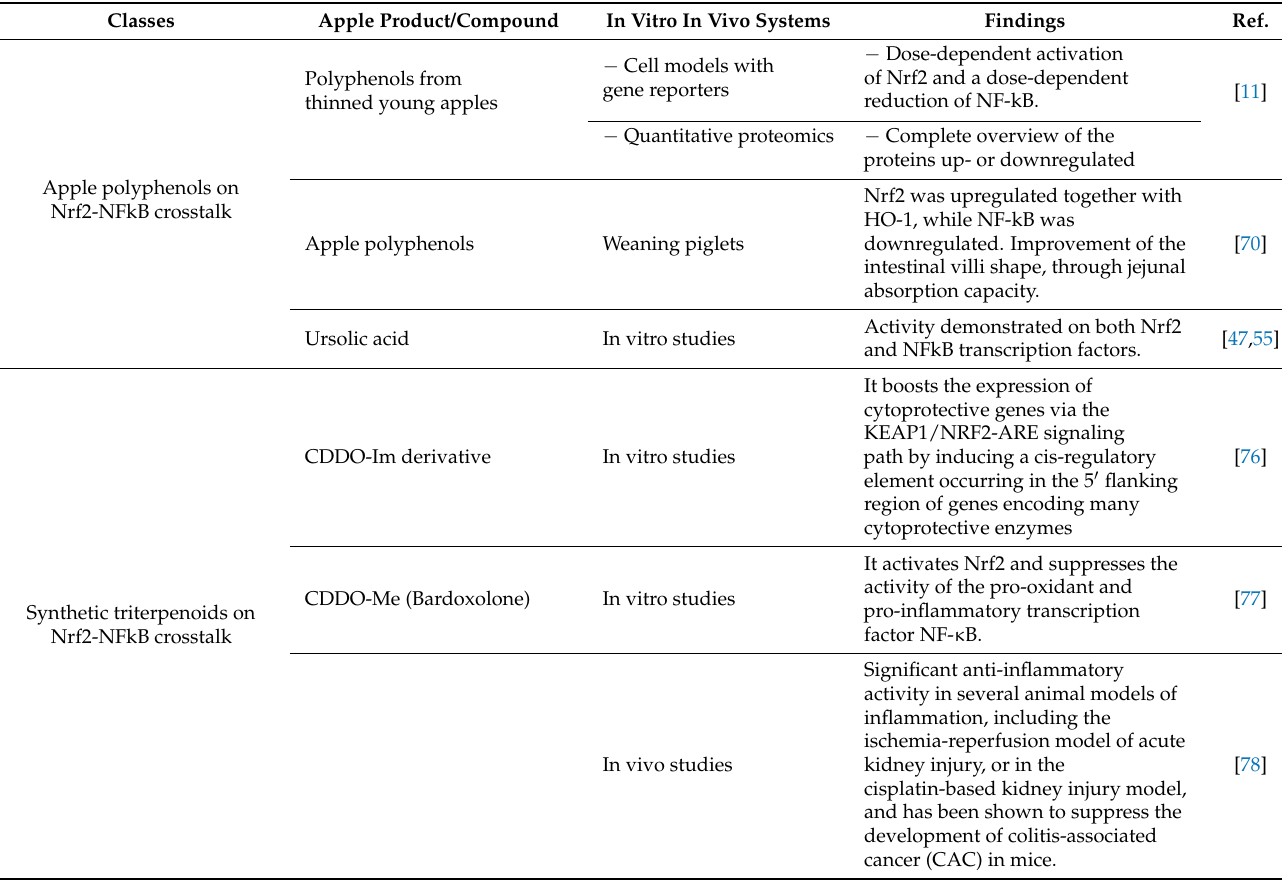
Table 3. Summary of the compounds/classes acting on both Nrf2 and NF- κ B pathways, the tests performed and results